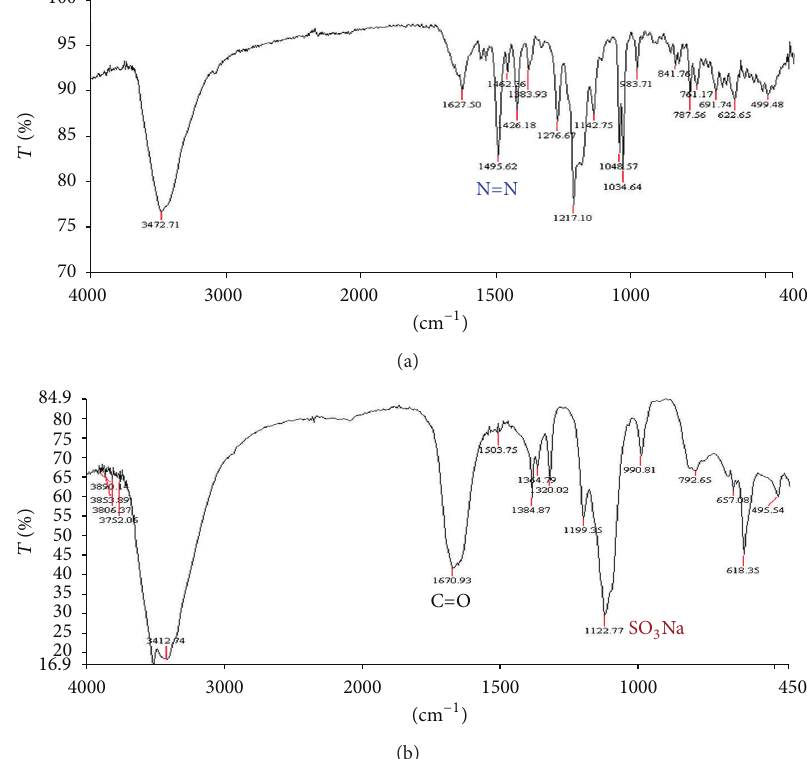
Figure 10: FTIR spectra for OG decolorization and demineralization (a) before and (b) after UV/ZnO photocatalytic degradation. The operating conditions were the same as in Figure